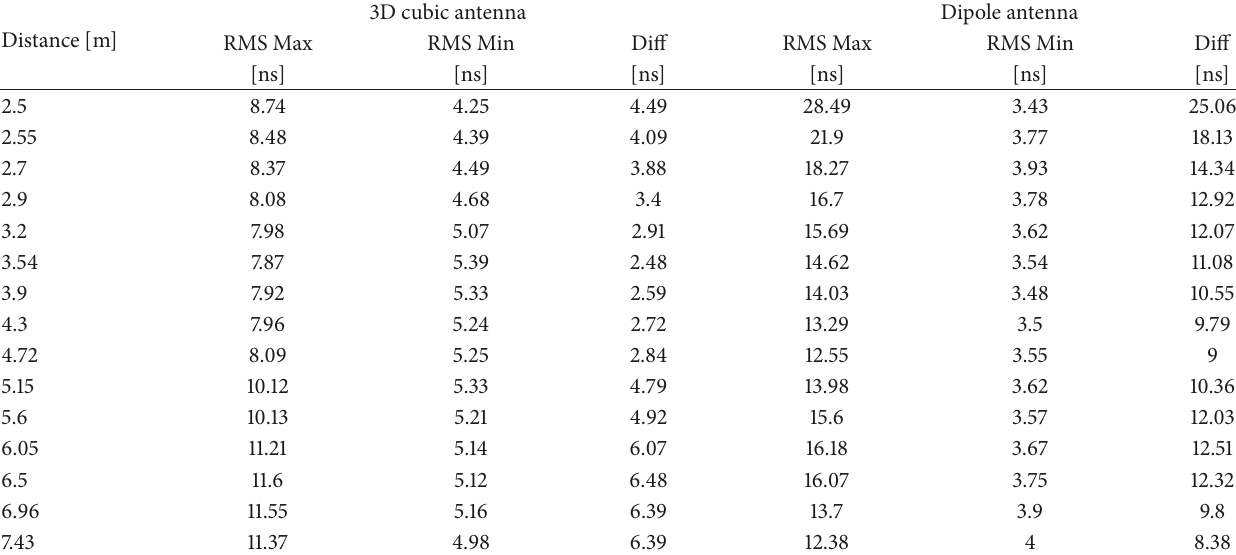
Table 4: Difference between RMS Max and Min in the LOS